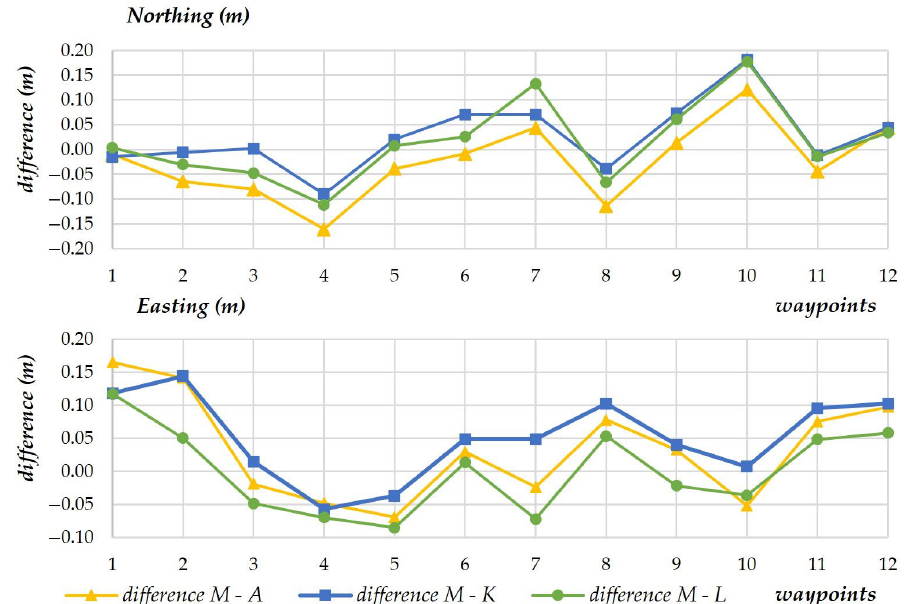
Figure 9. The average differences between model values and the measured values. The scatterplots presenting the standard deviation for every measuring device revealed low data spread. On the X-axis, the standard deviation of the measured values ranged from 0.01 m to 0.04 m for most points. Standard deviation values were two or three times higher only in sporadic cases (Figure 10). The measurements of the Y-coordinate were more stable, and standard deviation ranged from 0.01 m to 0.07 m for all waypoints.